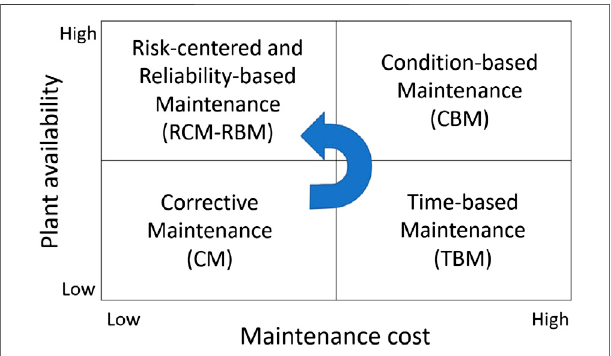
FIGURE 2 | Maintenance strategies regarding their costs and the resulting plant availability; the arrow indicates the evolution of the strategies.